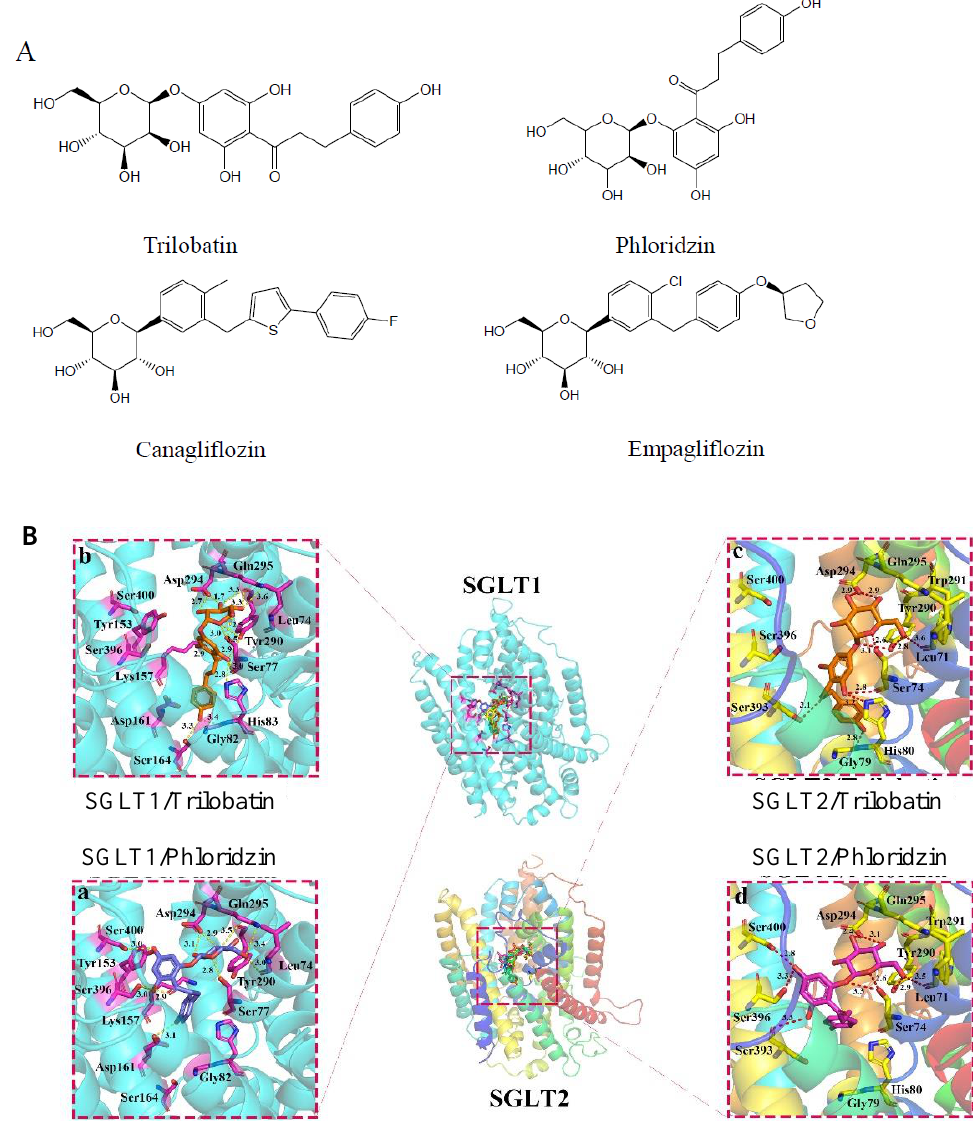
Figure 1. The results of molecular docking. ( A ) The structure of trilobatin, phloridzin, canagliflozin, empagliflozin. ( B ) The interaction between the indicated inhibitors and Na + - d -glucose co-transporter (SGLT)1/2.